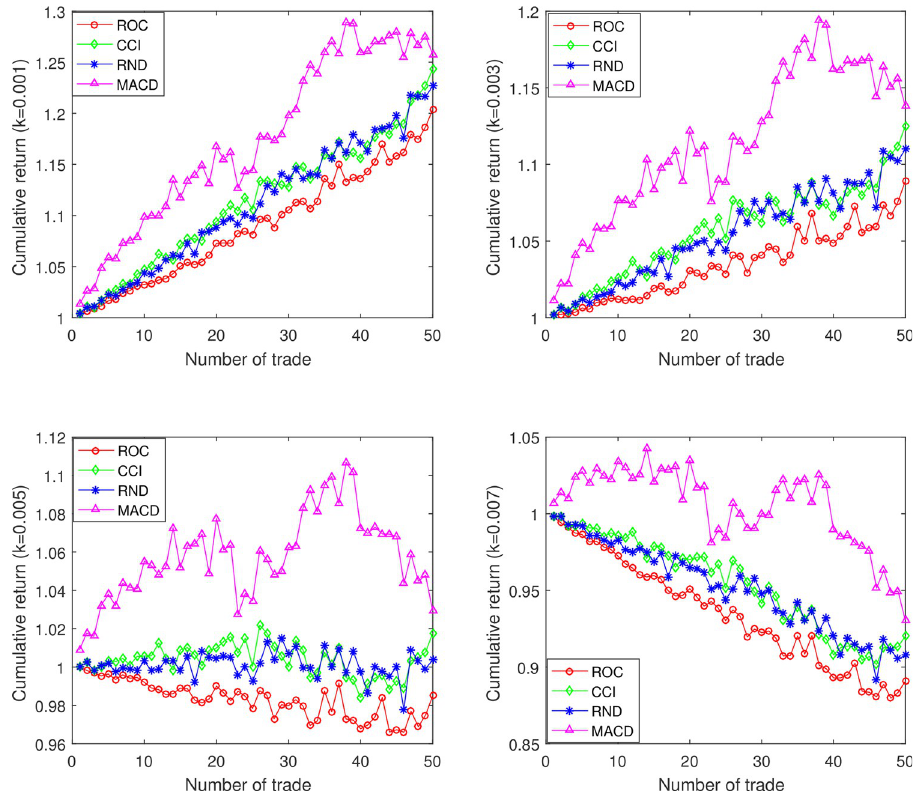
Fig 5. The influence of the number of trades (n) on the cumulative return in DJIA. From top to bottom, from left to right, k takes 0.001, 0.005, 0.003 and 0.007 respectively. See text for additional analysis.